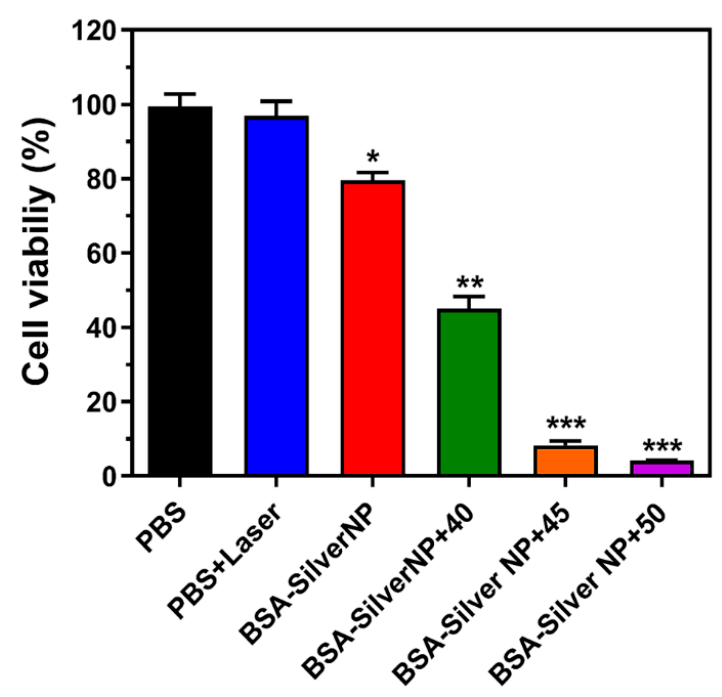
Figure 7. Anti-cancer activity of BSA-Silver NPs with photothermal treatment. Cytotoxic effects of laser irradiation with or without treatment of BSA-Silver NPs were evaluated on B16F10 cells. Laser power was set to achieve maximum mean temperatures of 40, 45, or 50 °C. The statistically significant differences in the cytotoxicity levels were compared by 1-way ANOVA (Tukey’s multiple comparison test as the post hoc test). * p < 0.05, ** p < 0.01, *** p < 0.001 vs. PBS control. (BSA-Silver NPs: BSA-coated silver nanoparticles).